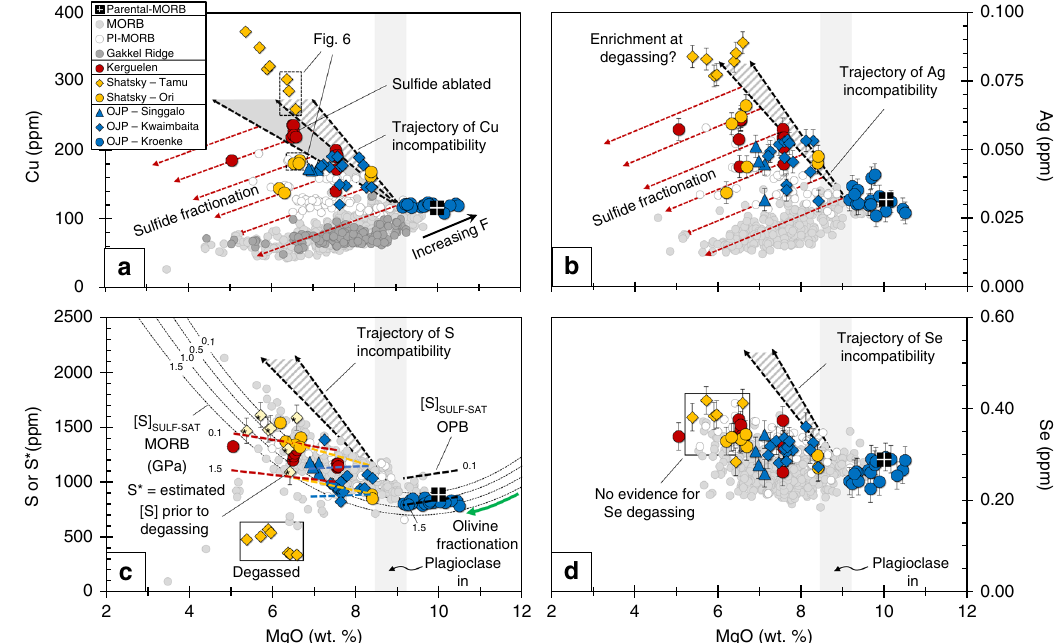
Fig. 1 Chalcophile element variations during crustal differentiation of OPB and MORB. a [Cu], b [Ag], c [S] and d [Se] versus [MgO]. The primitive Kroenke magmas have compositions which are similar to parental-MORB and are offset to higher [Cu] at a given [MgO] than samples from the ultra-slow spreading Gakkel Ridge, which are an example of low-degree partial melts 50,51 . Trajectories of increasing [Cu], [Ag], [S] and [Se] in a sul fi de-under- saturated melt (gray-dashed triangle) are modeled assuming that these elements are perfectly incompatible and thus have a bulk-D of ~0. An additional trajectory for Cu in a sul fi de-under-saturated melt is modeled using available partition coef fi cients for Cu in silicate phases ( D Cu values taken from ref. 39 ), giving the gray fi eld on a . Many of the OPB samples plot below the “ incompatible ( D = 0) trajectories ” , suggesting that the magmas are sul fi de-saturated. Sul fi de fractionation lines (red dashed lines, calculated using the slope for Cu and Ag in sul fi de-saturated MORB magmas; ref. 1 ) suggest that the proportion of sul fi des fractionated from OPB and MORB are comparable once saturation is achieved. OPB magmas saturate in sul fi de at lower [MgO] than MORB. Unlike S, Se is not degassed from the Tamu Massif samples. Except Se (see Methods), data for MORB, parental-MORB and the Gakkel Ridge are taken from Jenner and O ’ Neill 23 , Jenner 1 and Gale et al. 50 , respectively. Error bars for Se and Ag are given as the 1SD error on repeat analysis of the NWLSC Se and Ag standards (see Methods), with error bars on S* representing the propagated 1SD error of